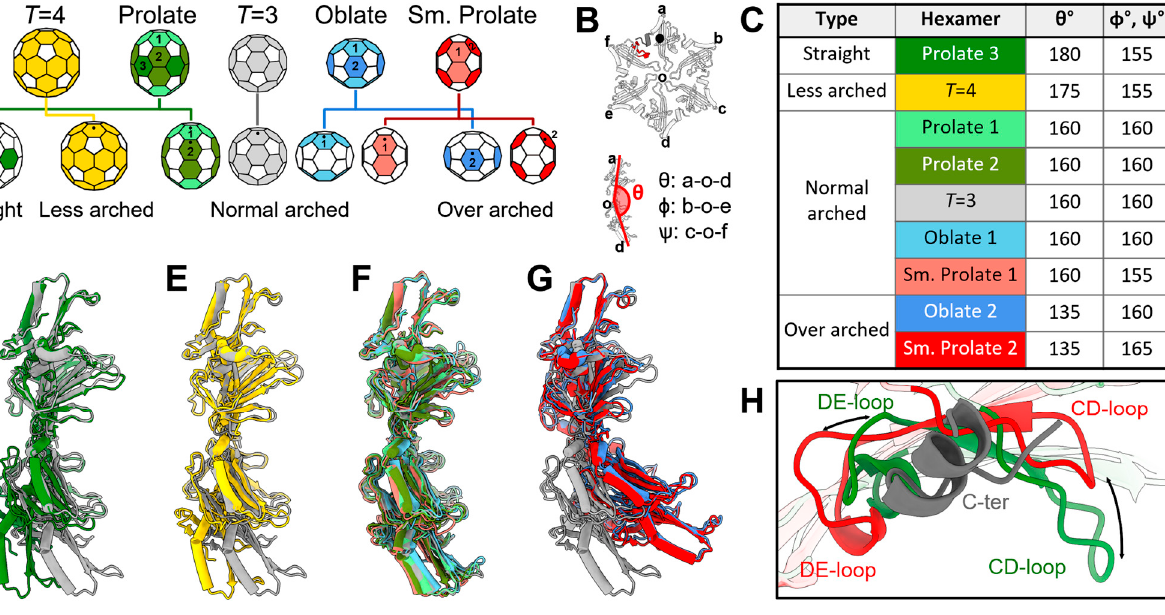
Figure 4. Plasticity in the hexamers of different Q β VLPs. ( A ) Different forms of the VLPs with the pentamers in white and hexamers colored. The conformations of the hexamers are classified to be “straight”, “less arched”, “normal arched”, and “over arched”. ( B ) The model of a hexamer with the six subunits labeled from a to f. The black dot indicates the relative orientation of the hexamer in Panel A. The curvature of the hexamer can be defined by three arch angles, θ (between subunits a and d), ϕ (between subunits b and e), and ѱ (between subunits c and f). ( C – F ) Structural overlay of the hexamers in each type (colored as in Panel A) against the regular T = 3 hexamer (grey). The models are aligned based on subunit a of the hexamers as labeled by a black dot in Panels A and B. ( G ) The table showing the values of θ , ϕ , and ѱ for each form of the VLPs. ϕ and ѱ have the same value for each VLP form due to the symmetry. The names of the hexamers are highlighted with the corresponding color in Panel A. ( H ) The relative motion between the C-terminus (dark grey) of one subunit and the CD/DE-loops of its neighbor. The black arrows indicate the movements of the CD/DE-loops between the over arched (red) and straight (green) hexamer conformations. The location of the C-terminus and the CD/DE-loops are labeled in Panel B with the corresponding colors, grey and red, respectively.